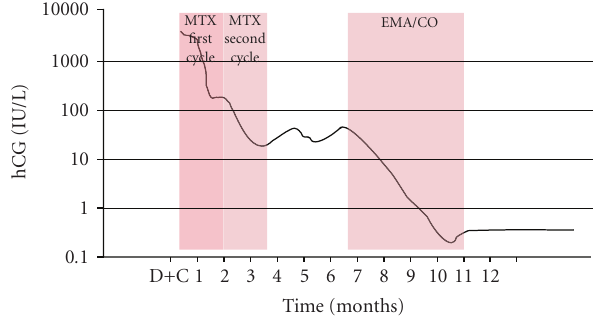
Figure 2: Graphical overview of hCG-levels showing initial satisfac- tory response (A) to two cycles of methotrexate interval, followed by a plateau-phase (B), indicating transition into a gestational trophoblastic tumour. Six cycles of EMA/CO chemotherapy were given subsequently